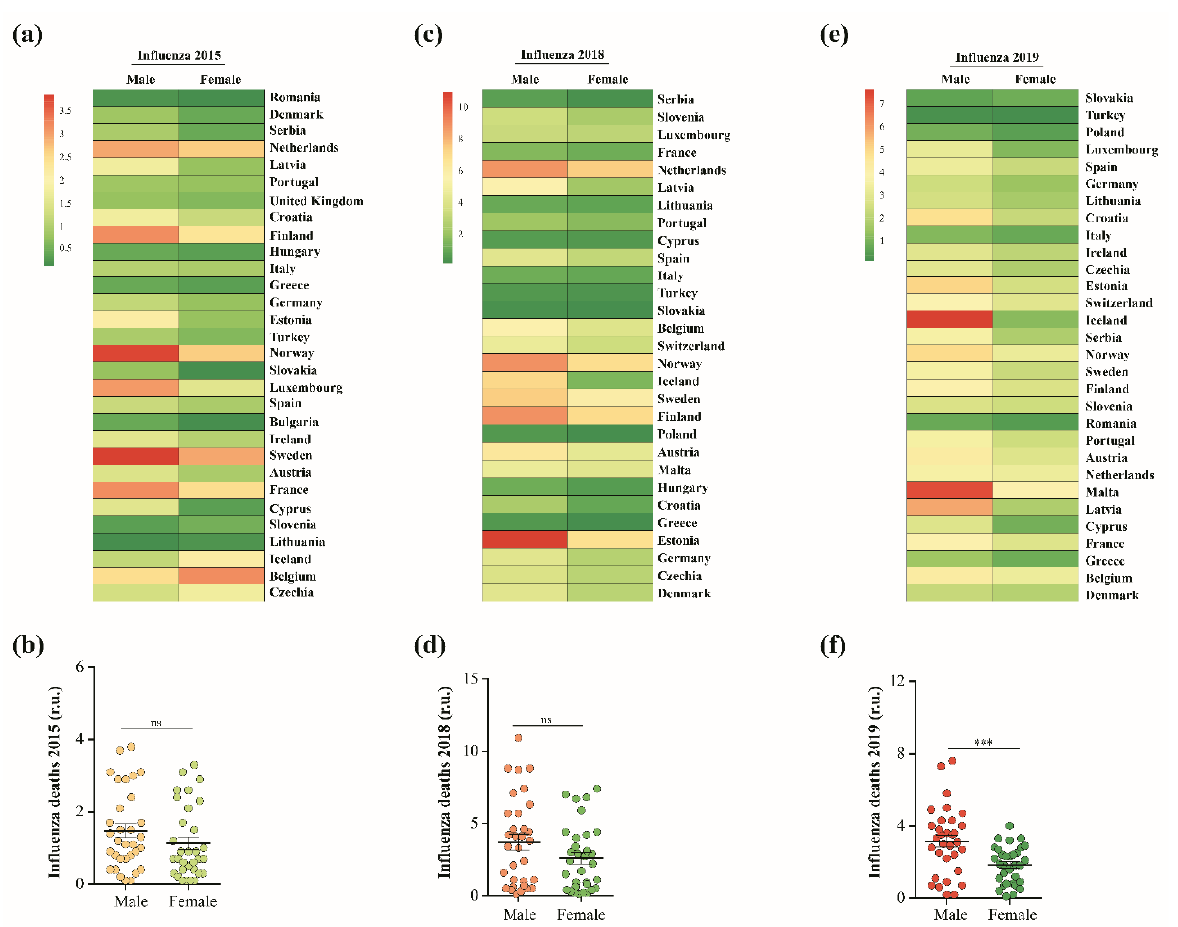
Figure 6. Sex-disaggregated data for influenza deaths during 2015, 2018, and 2019: ( a ) heatmap depicting sex differences in the death rates of influenza during 2015 in 30 EU countries; ( b ) mean differences between datasets representing both sexes in a; ( c ) heatmap depicting sex differences in the death rates of influenza during 2018 in 29 EU countries; ( d ) mean differences between datasets representing both sexes in c; ( e ) heatmap depicting sex differences in the death rates of influenza during 2019 in 30 EU countries; ( f ) mean differences between datasets representing both sexes in e. Results ( b , d , f ) are expressed as mean ± SEM. ns denotes no significance and *** p ≤ 0.001.